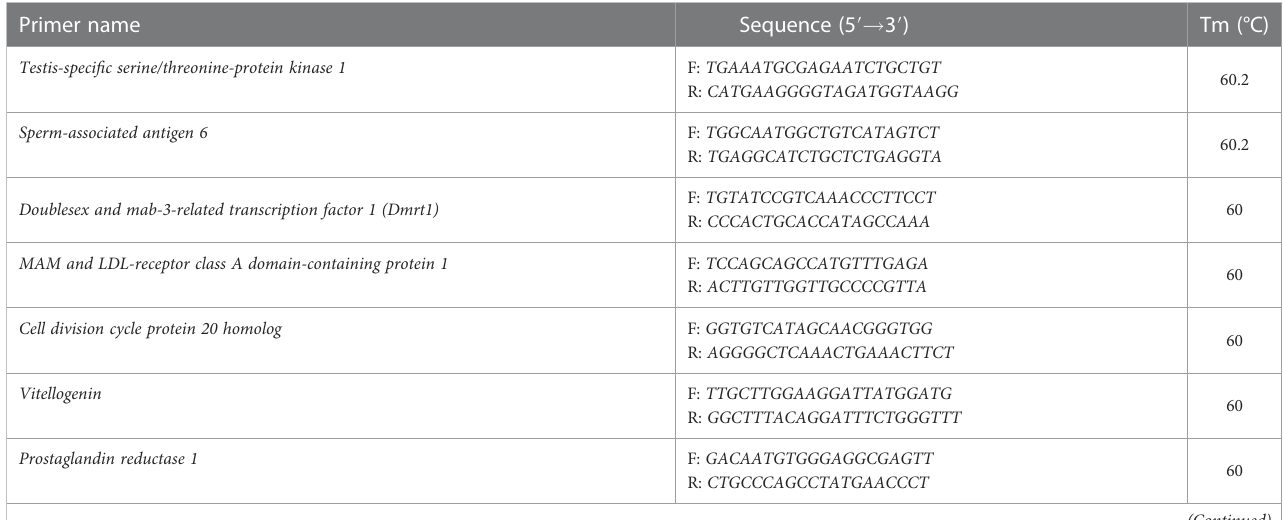
TABLE 1 Speci fi c primers used to in